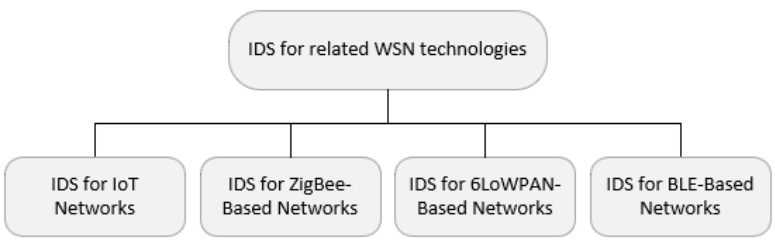
Figure 8. Intrusion Detection Systems (IDS) for related WSN